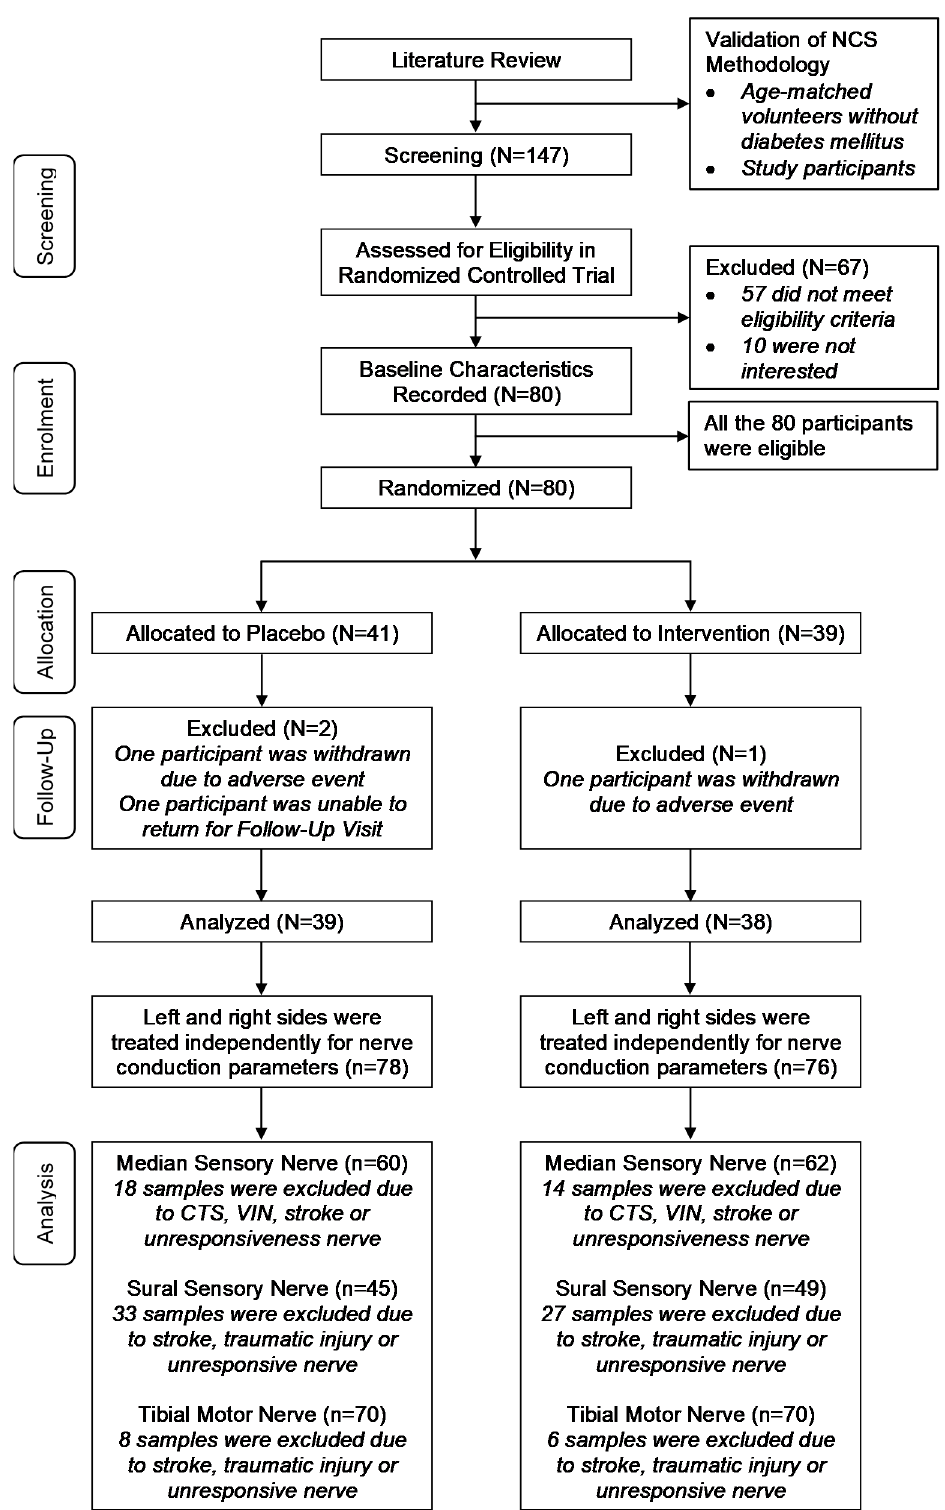
Figure 1. Study design flow chart. N: Number of participants; n : Sample size for nerve conduction Figure 1. Study Design Flow Chart. N: Number of participants; n : Sample size for nerve conduction parameters; CTS: Carpal tunnel syndrome; VIN: Vibration-induced parameters; CTS: Carpal tunnel syndrome; VIN: Vibration-induced neuropathy.